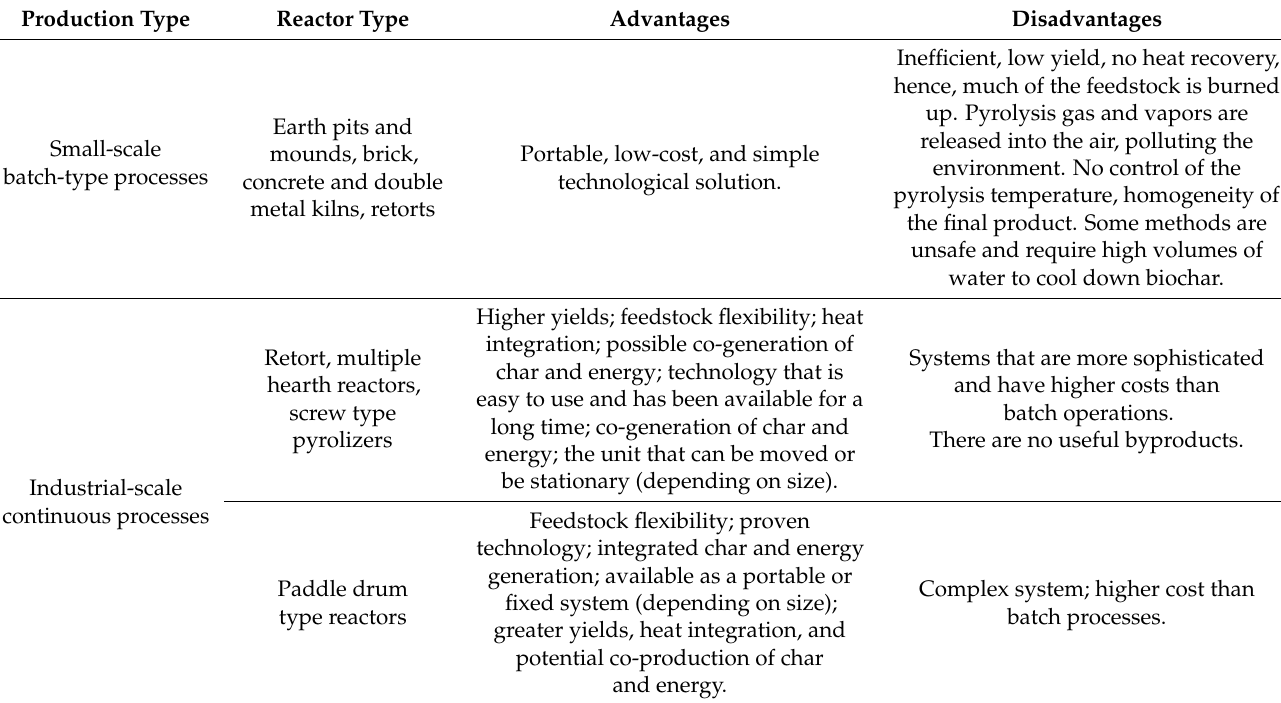
Table 1. Comparison of various types of reactors for biochar production